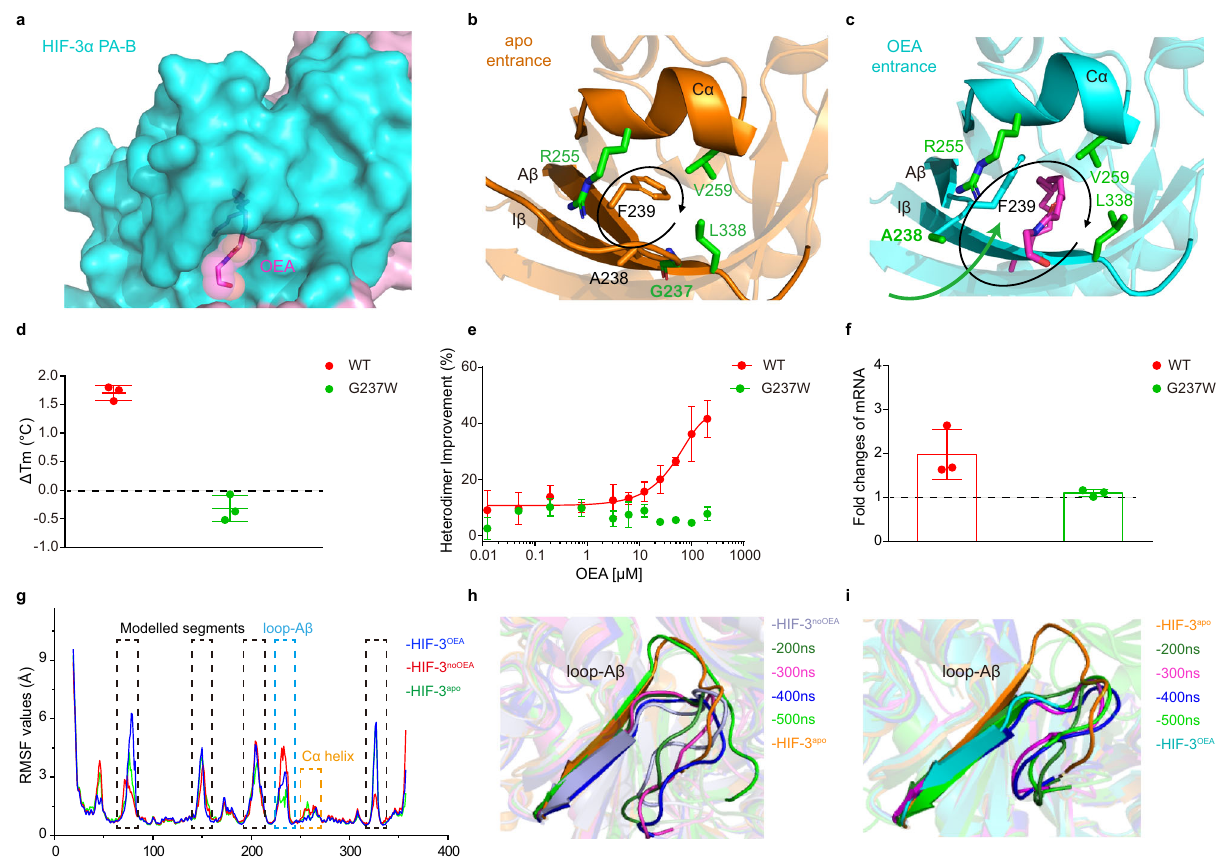
Fig. 4 The loop-A β region of HIF-3 α gates the OEA pocket entrance. a An enlarged view of OEA in the binding pocket of HIF-3 α , shown in the magenta. b , c Comparison of the HIF-3 α PAS-B entrance position in the apo ( b ) and OEA-bound structures ( c ). The entry route of OEA is simply marked with a green arrow. The residues surrounding the entrance are labeled in green, and all residues are shown with their side chains, except G237. d The Δ T m values of wild-type HIF-3 α (WT) and G237W mutant both heterodimerized with ARNT were measured by PTS in the presence of 20 μ M OEA. e The effect of OEA on the heterodimerization between HIF-3 α mutant G237W and ARNT, as monitored by TR-FRET. f Comparison of fold changes in the mRNA expression of HSPA6 between overexpressed wild-type HIF-3 α and the mutant G237W after OEA (25 μ M) treatment. g C α RMSF plots for the HIF-3 α subunit in each system. The highly fl exible regions including modelled linkers (black) and loop-A β (cyan) are highlighted. And the region of C α helix marks in orange. h , i Snapshot structures extracted from the trajectories of HIF-3 noOEA ( h ) and HIF-3 apo ( i ). Error bars, mean ± SD.; n = 3 (biological replicates) for ( d – f